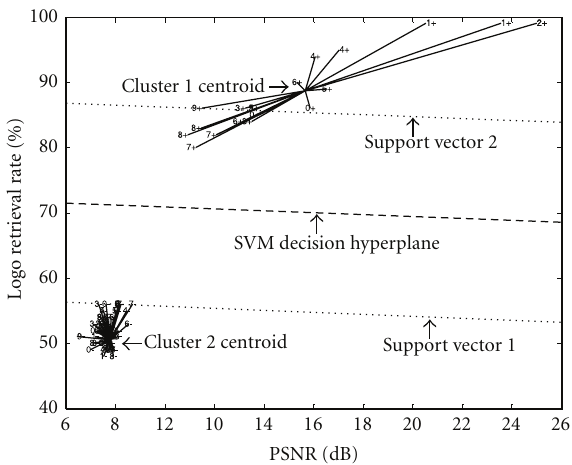
Figure 7: SVM classification and K -means clustering results by the TBLK approach of the proposed MSB-based scheme. Note that the distance between support vectors by SVM [27] is d = 31 . 5 and cluster 1 and cluster 2 are positive and negative clusters, respectively, by K -means clustering algorithm [28]. Attack numbers 0–9 are referred using Table